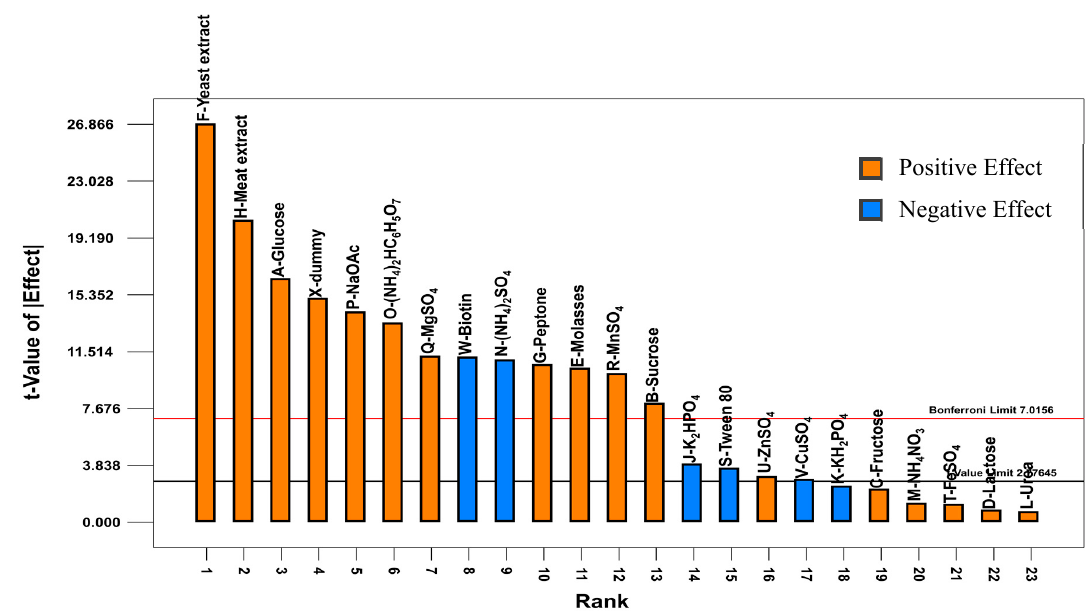
Figure 2. Effects of medium compositions on growth of P. acidilactici TP-6. Figure 2. E ff ects of medium compositions on growth of P. acidilactici